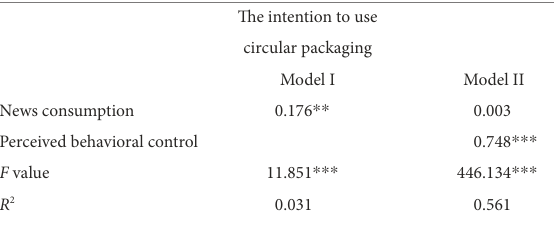
TABLE 4 Analysis of news consumption and the subjective norm toward the use of circular packaging. Independent variable Dependent variable